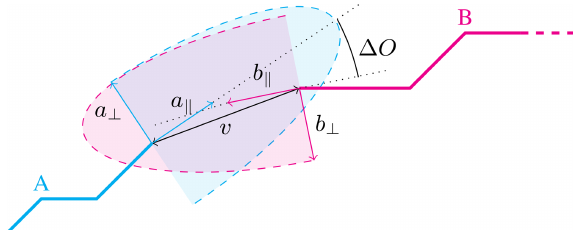
Figure 3. Sketch of two segments A and B illustrating the princi- ple behind the elliptical distance. In the distance computation the component pointing in the direction perpendicular to the segment is weighted by a factor of e . Within the shaded area the elliptical distance is below a threshold D 0 . If the endpoints of both segments lie within the area where both shaded half ellipses overlap, they are considered for reconnection. The dotted lines indicate the orienta- tion of lines connecting the start and end points of both segments and the angle (cid:49)O is the difference in orientation. v is the vector connecting the endpoints of both segments as defined in Eq. (2). a (cid:107) and a ⊥ are basis vectors aligned in the direction of segment A , respectively b (cid:107) and b ⊥ for B